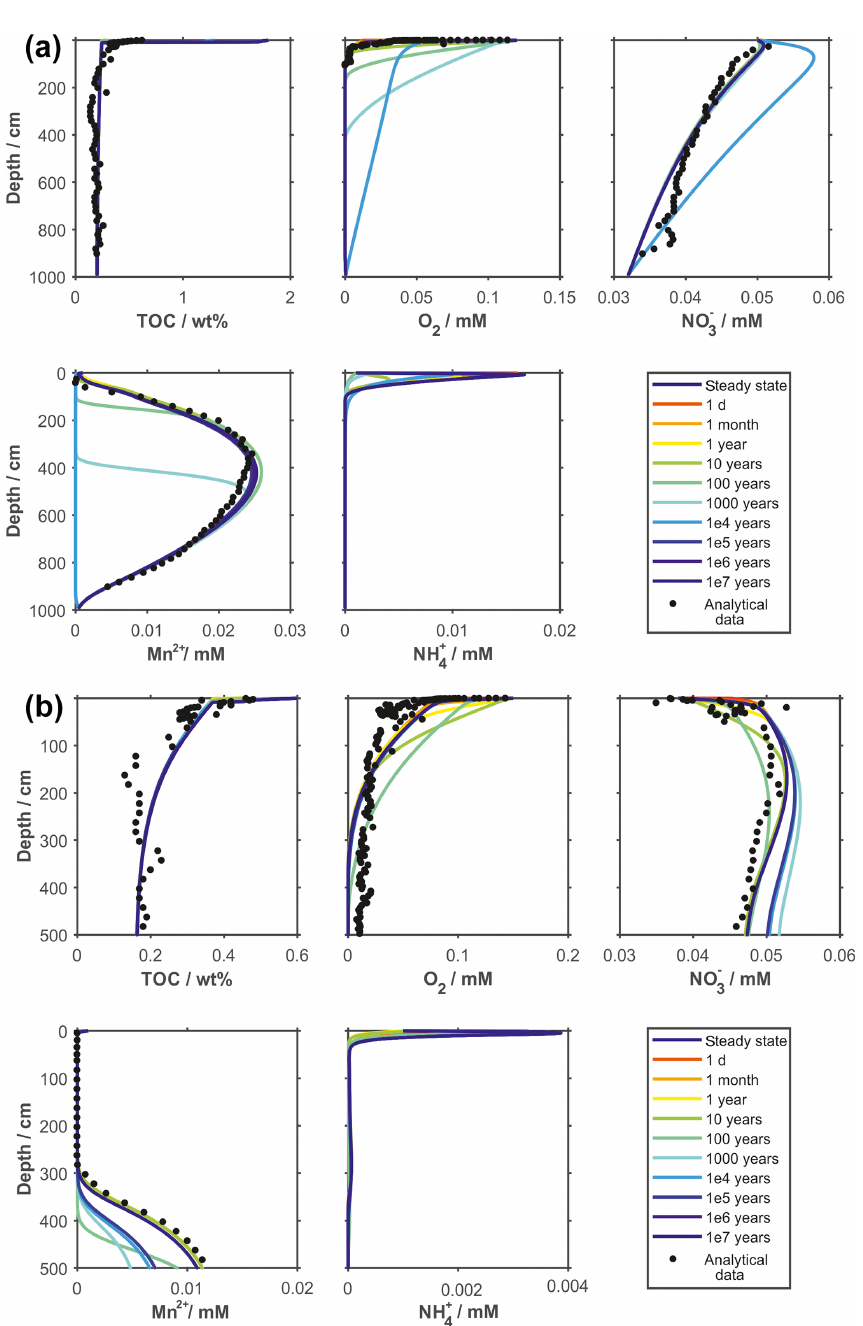
Figure 5. Model results of the transient transport-reaction model showing depth profiles of TOC, O 2 , NO − disturbance in the German BGR-RA area and (b) the IOM-BIE disturbance in the eastern European IOM area. The model is adapted after the steady-state transport-reaction model presented in Volz et al. (2018) and shows the response of the geochemical system in the sediments if steady-state conditions are disturbed by the removal of the upper 10cm (BGR-RA; average disturbance depth of BGR-PA and BGR-RA; see Table 3) and 7cm (IOM; see Table 3) of the sediments while maintaining the same boundary conditions but with reduced bioturbation over the first 100 years after the